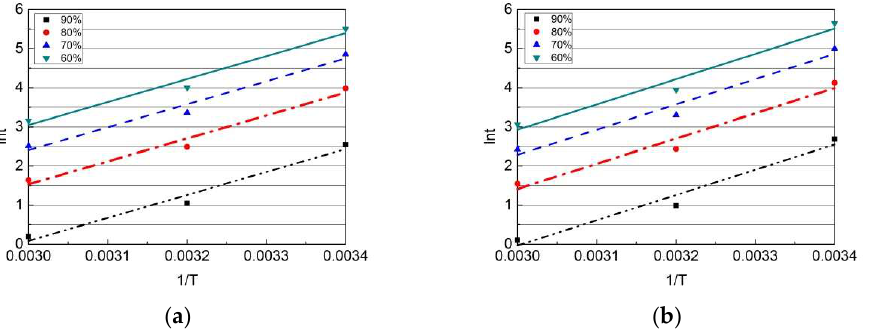
Figure 22. Arrhenius graphs based on the third prediction model: ( a ) G1; ( b ) G2. Table 11. Values of E a / R (G1) based on the third prediction model.